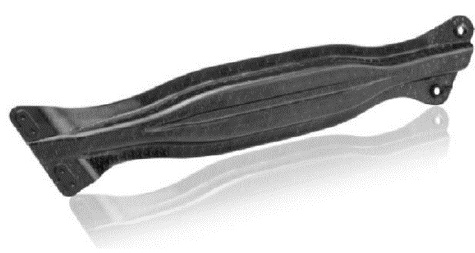
Figure 1. Side impact door beam made of continuous fiber-reinforced organic sheet and injection molded thermoplast [19].